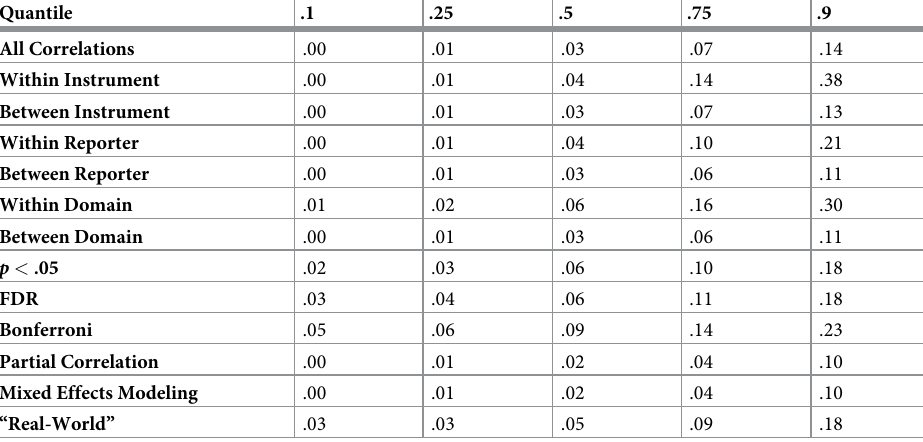
Table 1. Effect size (in Pearson’s r) quantiles for analytic